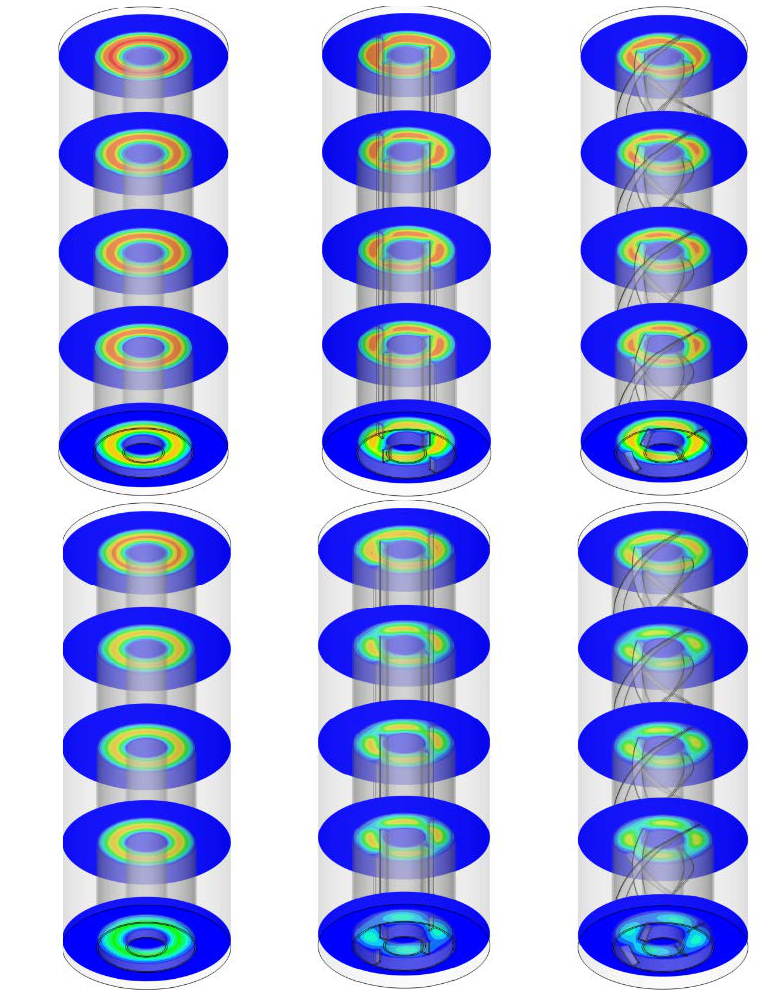
Figure 4. Evolution of temperature field for the cases of no fins, straight fins, and twisted fins at different time spans of solidification progress.